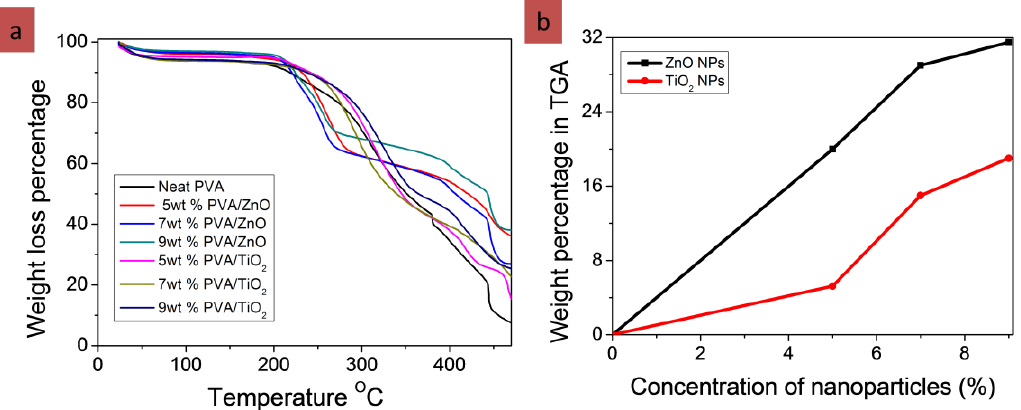
Figure 9. Results of TGA ( a ) showed the degradation behavior; ( b ) content percentage of ZnO and TiO 2 NPs in 6 mg of sample .